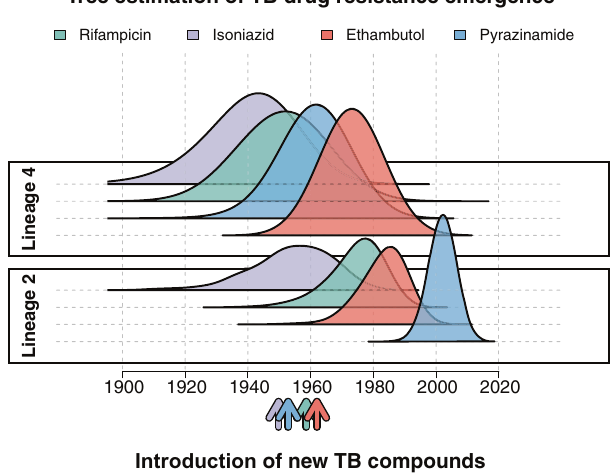
Fig. 2 Inferred posterior density distribution of the earliest occurrence of resistance to fi rst line antituberculous drugs. Posterior density distribution inferred using a time-calibrated phylogeny for both lineage 4 and lineage 2. Arrows represent the approximate time of